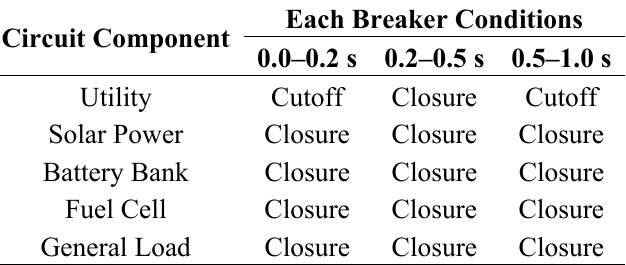
Table 2. The condition of each